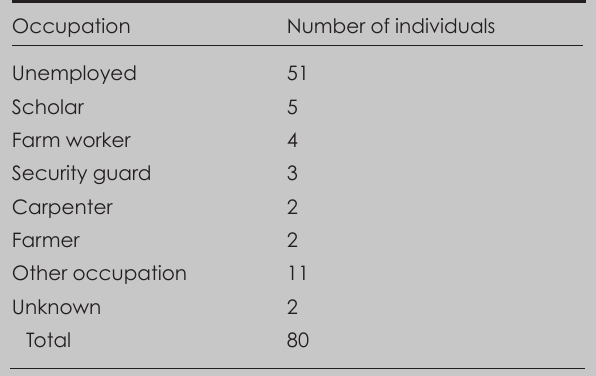
Table II. Occupation of the offenders